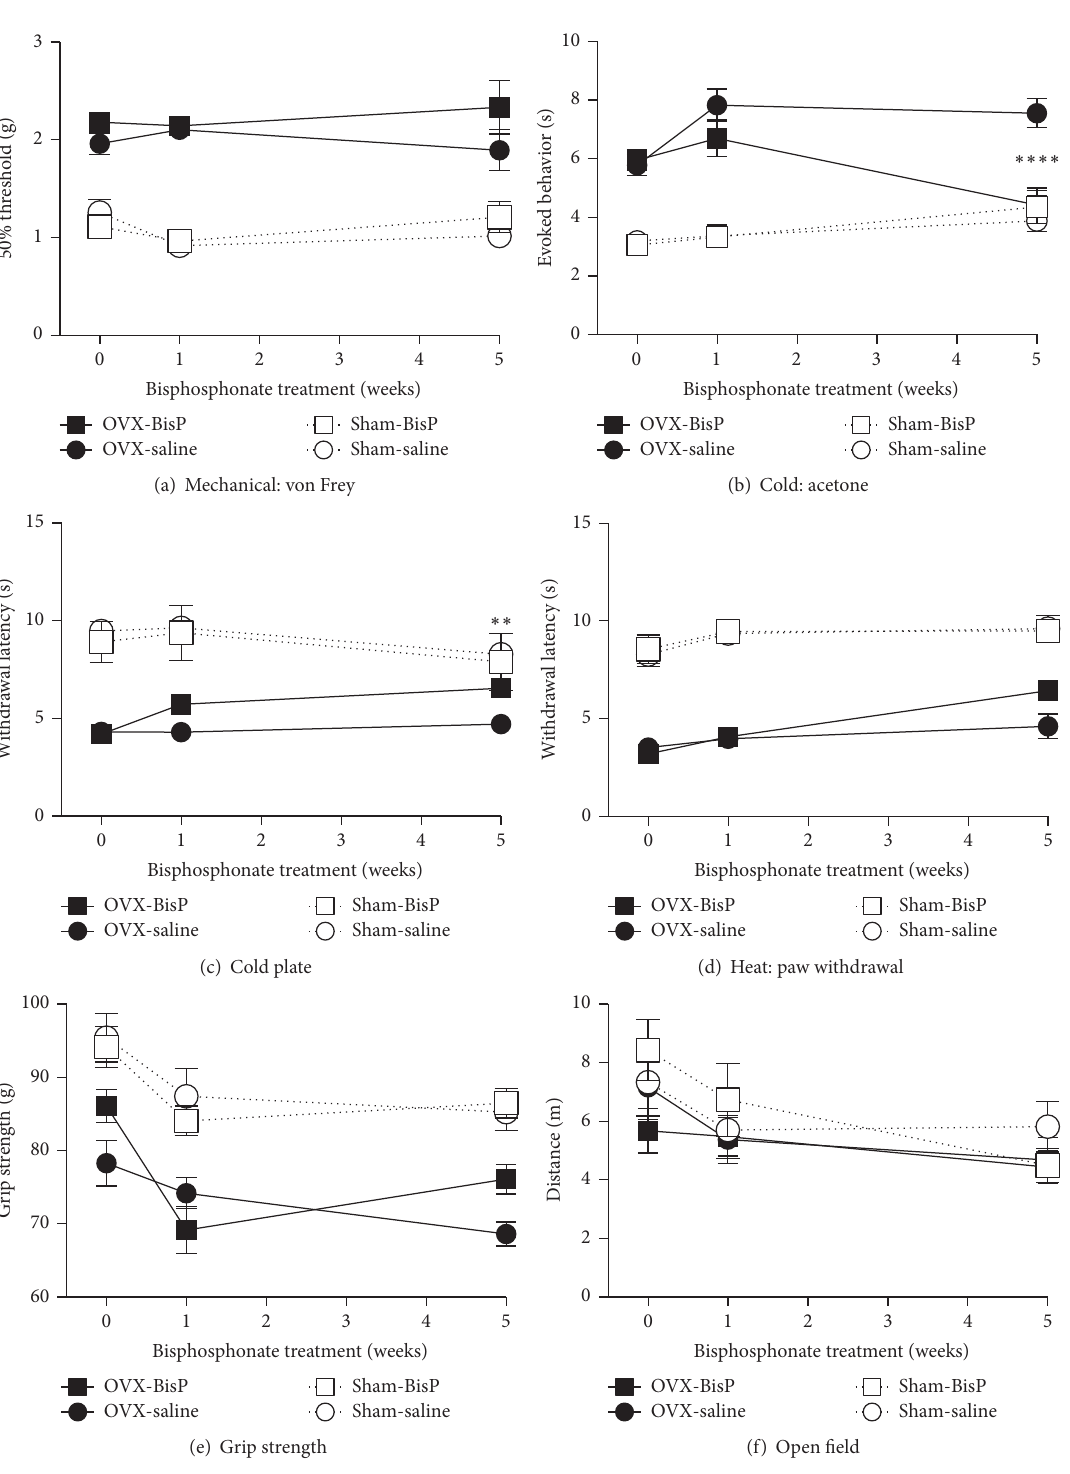
Figure 4: Efficacy of chronic bisphosphonate (pamidronate) treatment on chronic osteoporosis-related cutaneous and musculoskeletal pain and physical function. Pamidronate (0.25 mg/kg) was administered 5 days/week for 5 weeks, beginning 6 months after ovariectomies or sham surgeries. Pamidronate has no effect on cutaneous plantar hypersensitivity to mechanical stimuli (von Frey assay) (a) and reversed hypersensitivity to cold (acetone test) (b) and cold plate tests (c); it was ineffective against heat sensitivity in the radiant heat paw withdrawal assay (d). Pamidronate is also inactive in the grip strength assay (e) and open field test (f). Data are expressed as means ± standard error of the mean. OVX: ovariectomized; BisP: bisphosphonate; ∗∗ 𝑃 < 0.01 ; ∗∗∗∗ 𝑃 < 0.0001 ; and OVX group with pamidronate versus saline vehicle control, two-way analysis of variance (factors = group × time) followed by Tukey’s test for multiple